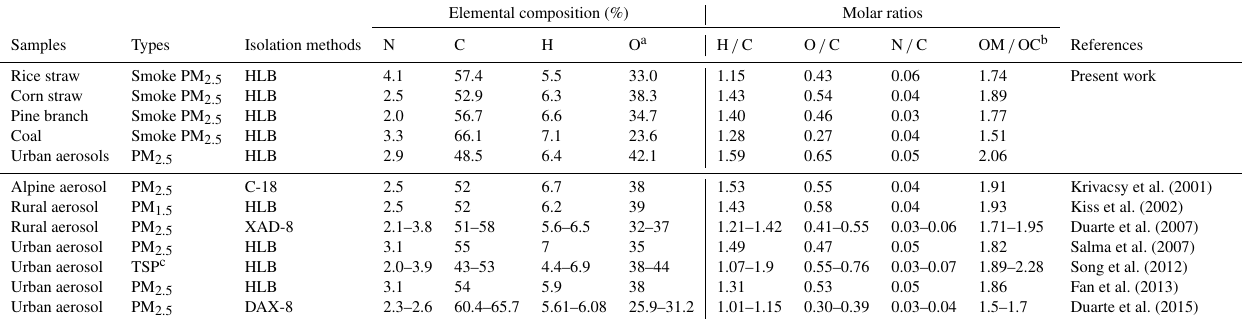
Table 3. Elemental composition and molar ratios of HULIS in smoke PM 2 . 5 from combustion of rice straw, corn straw, pine branch, and coal, and in ambient